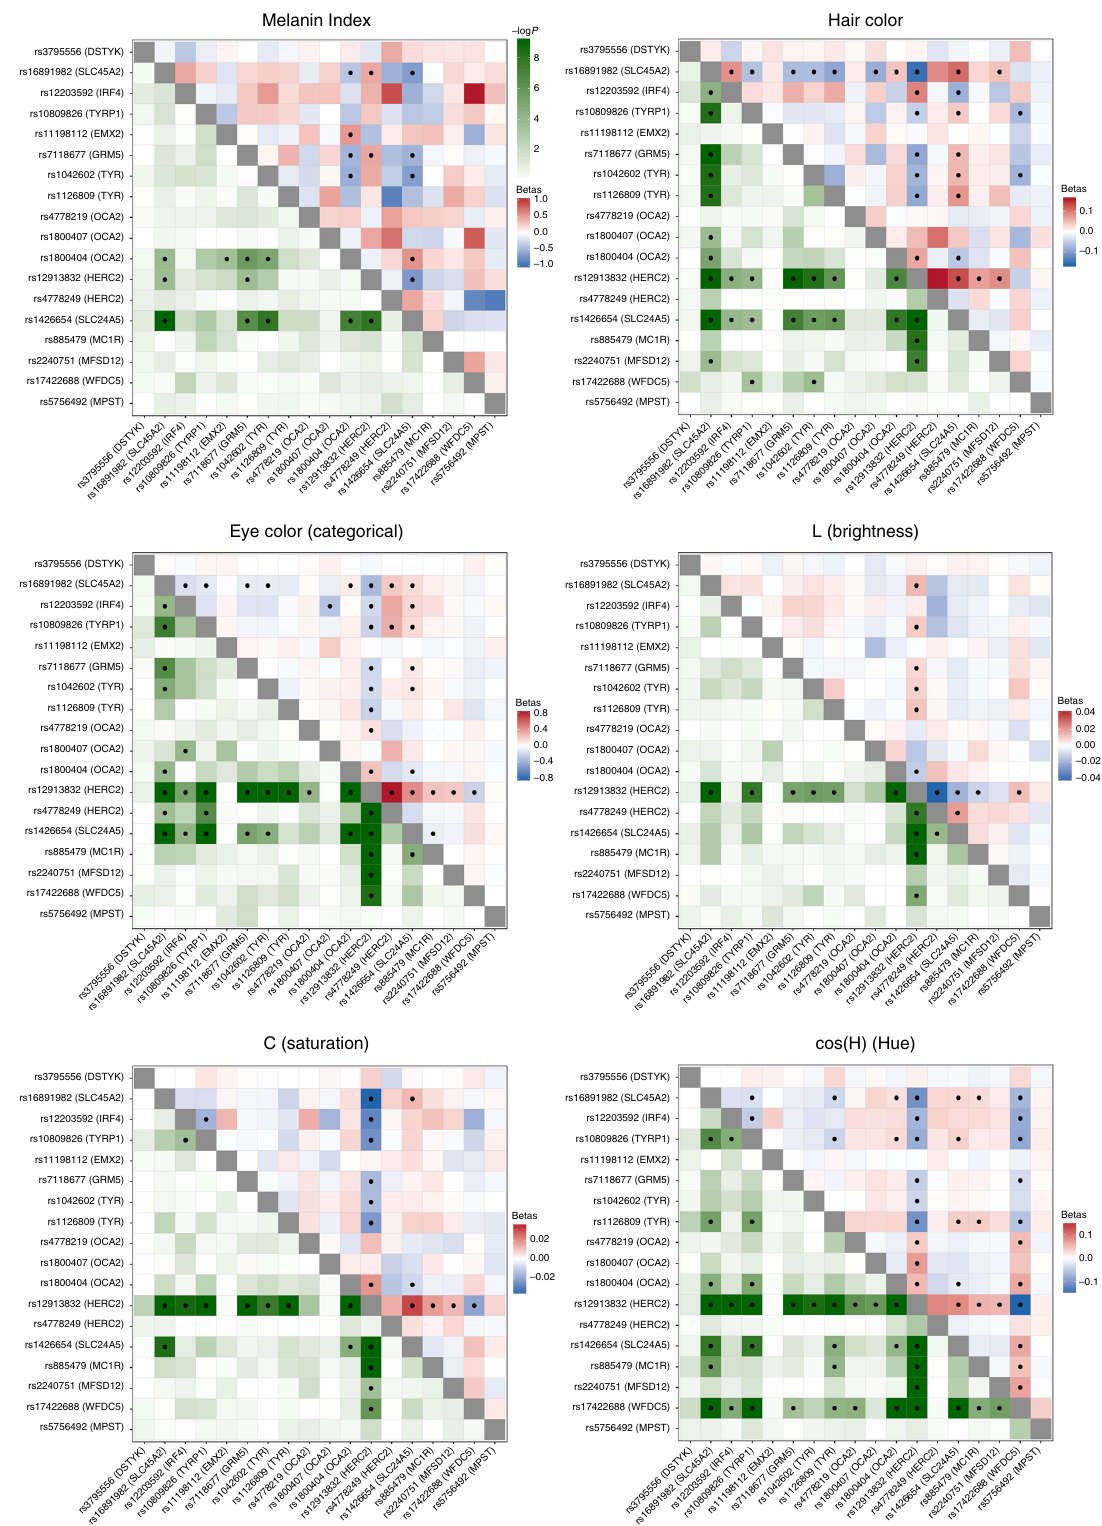
Fig. 5 Heatmaps of statistical interactions between the 18 index SNPs identi fi ed here. Each panel corresponds to a different trait. The lower left triangle represents − log 10 P values for the interaction term included in the regression model (with the color scale shown at the top). The upper right triangle represents regression beta-coef fi cients for each interaction term, colored from blue (negative effect) to white (no effect) to red (positive effect). As the scale for each trait is different, separate scales for effect sizes are shown next to each panel. Interactions that are signi fi cant (after Bonferroni correction) are marked with a black